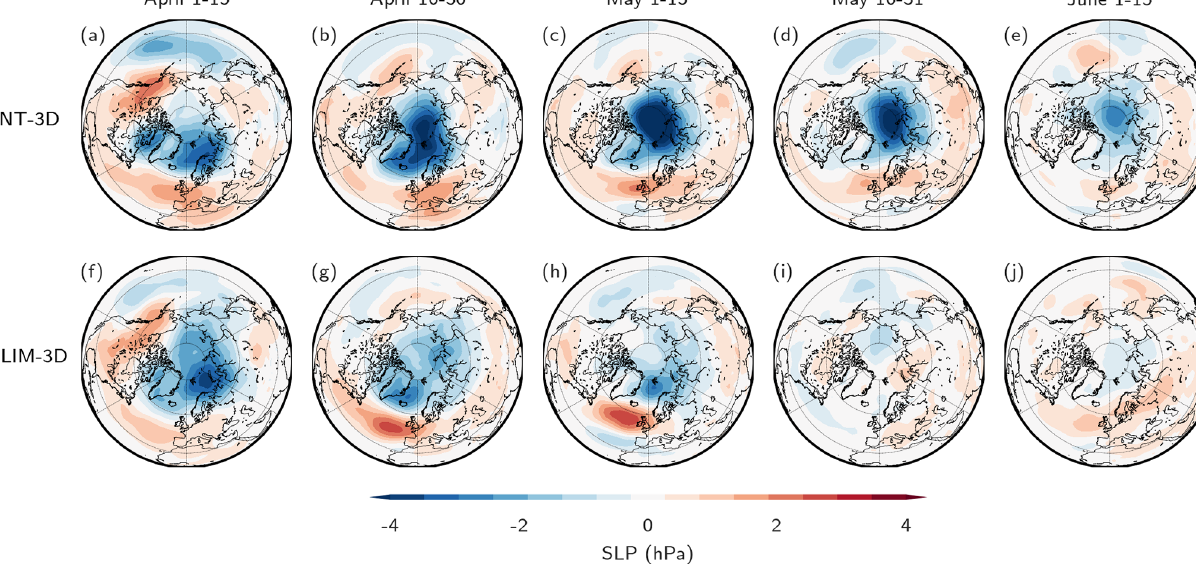
Figure 7. Seasonal evolution of SLP anomalies in low-ozone years in WACCM. Evolution of SLP anomalies from April to June in low-ozone springs in WACCM simulations with interactive ozone chemistry (a–e) and climatological ozone (f–j) . The mean ozone minimum date in INT-3D simulations is 20 April, while the mean FSW date is 10